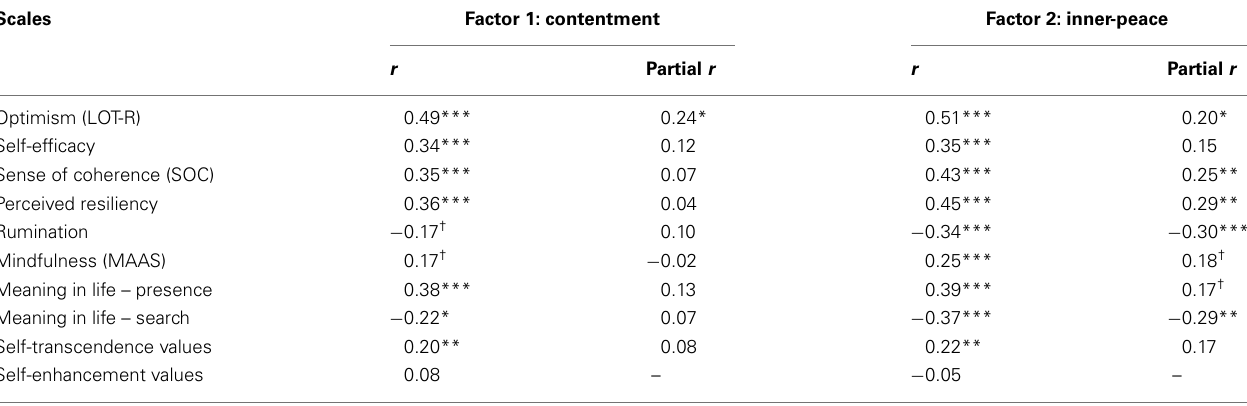
Table 7 | Correlations of the two components of SubjectiveAuthentic–Durable Happiness (i.e., contentment and inner-peace) with various convergent measures (Samples D and